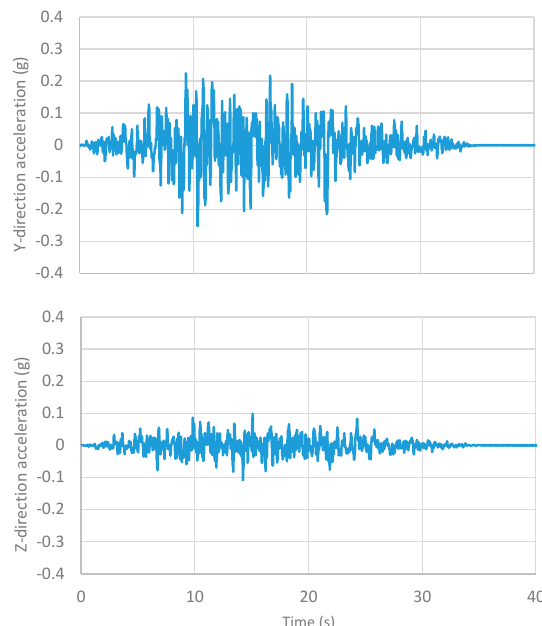
Figure 6. Artificial time-history seismic acceleration for T s = 0.6 and peak ground accelerations (PGAs) of 0.36, 0.252, and 0.108 g in the local X, Y, and Z directions.